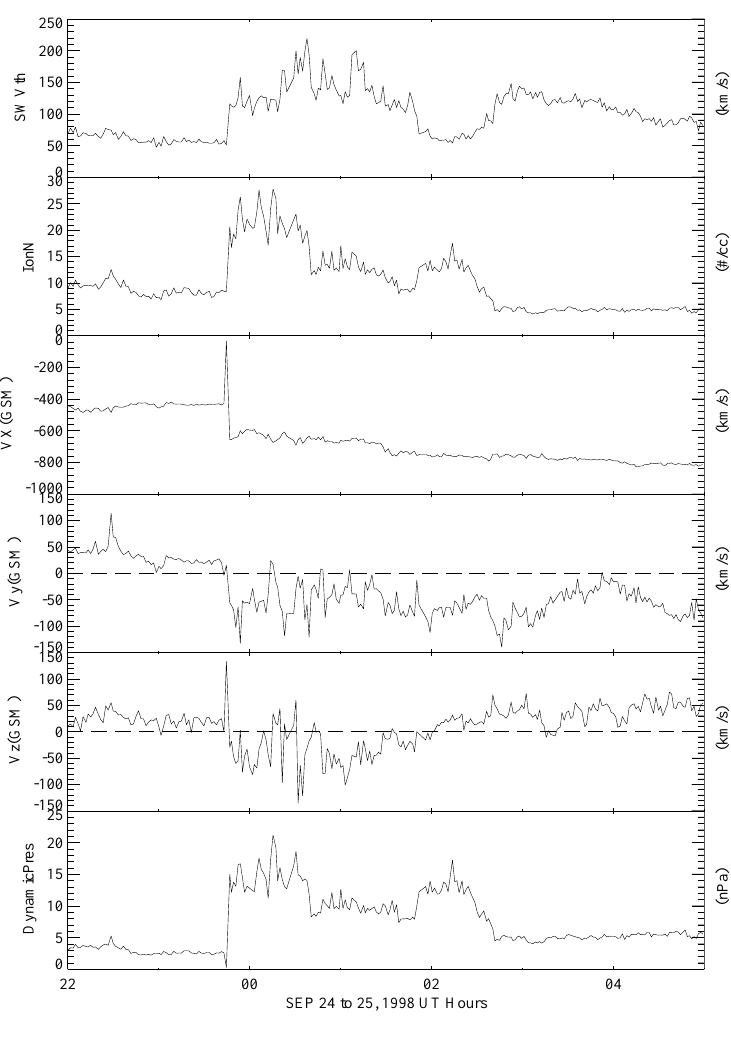
Fig. 7. Solar wind parameters offset by 24min on 24–25 September 1998. Observations by Wind/SWE of the solar wind (top to bottom) of the thermal velocity, V th ; solar wind ion density, N ; solar wind bulk velocity, V , in the GSM coordinates; and solar wind dynamic pressure, p = nV 2 x